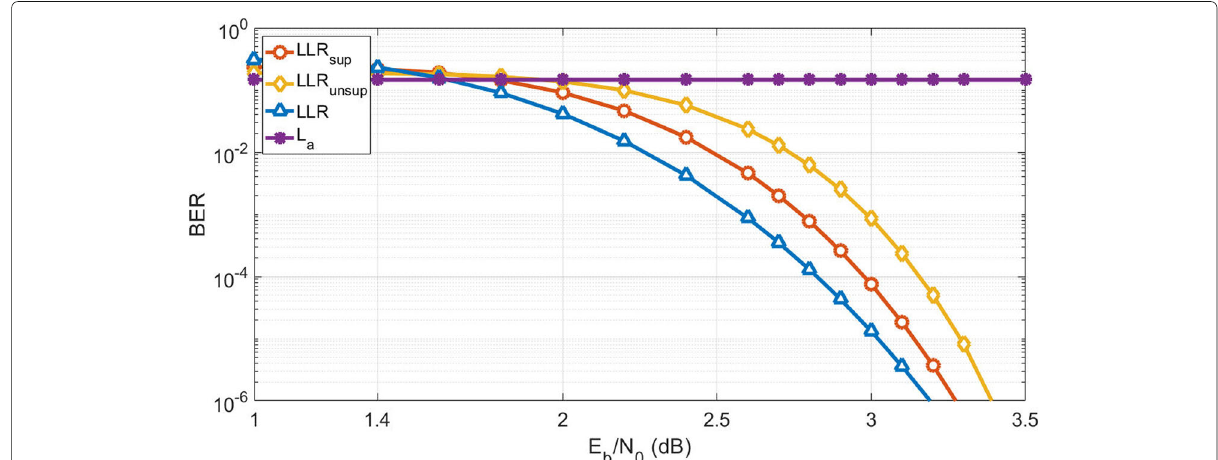
Fig. 9 BER comparison in highly impulsive Middleton class A noise. BER comparison as a function of E b / N 0 between the supervised, unsupervised, Gaussian designed LLR approximations and the LLR obtained by numerical integration, in highly impulsive Middleton class A noise with A = 0.1 and (cid:8) = 0.1